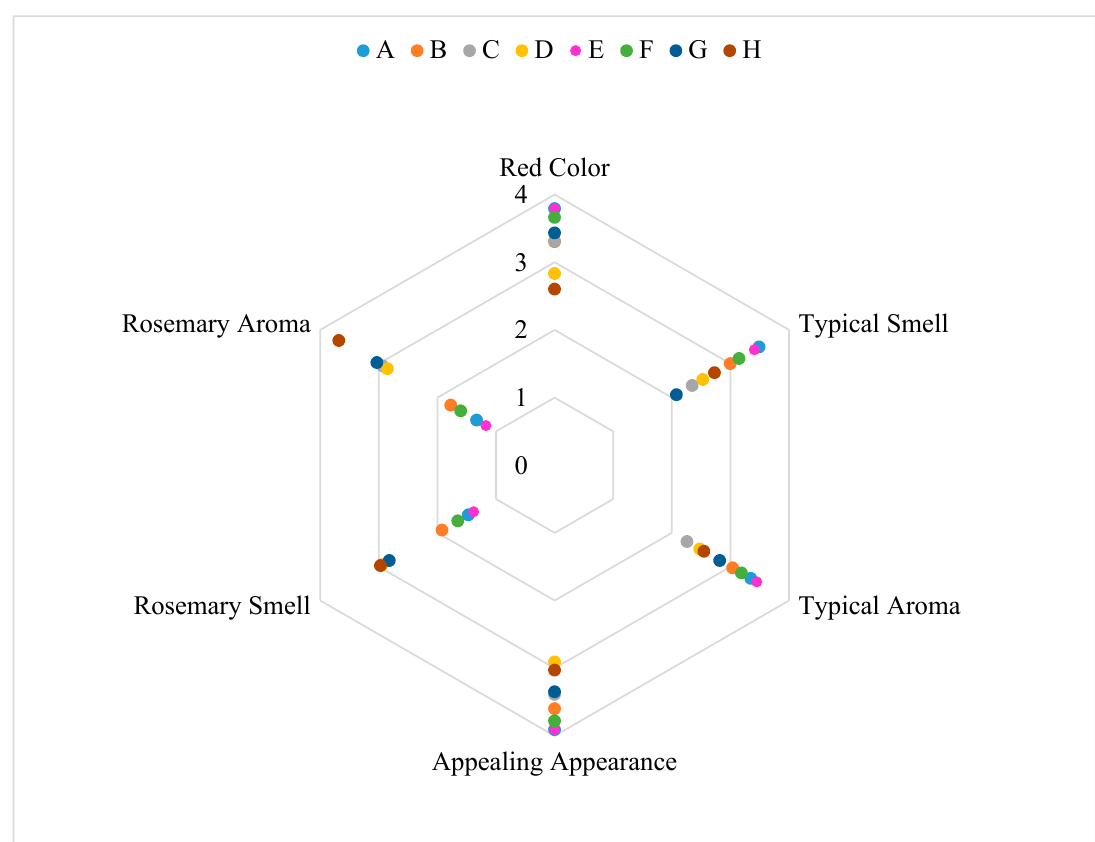
Figure 7. Results of the sensory analysis for other descriptors. (A): Salami slice packaged with the control film during a 90-days storage period evaluated without the packaged; (B): Salami slice packaged with the control film during a 90-days storage period evaluated with the packaged; (C): Salami slice packaged with the active film during a 90-days storage period evaluated without the packaged; (D): Salami slice packaged with the active film during a 90-days storage period evaluated with the packaged; (E): Salami slice packaged with the control film during a 30-days storage period evaluated without the packaged; (F): Salami slice packaged with the control film during a 30-days storage period evaluated with the packaged; (G): Salami slice packaged with the active film during a 30-days storage period evaluated without the packaged; (H): Salami slice packaged with the active film during a 30-days storage period evaluated with the packaged.